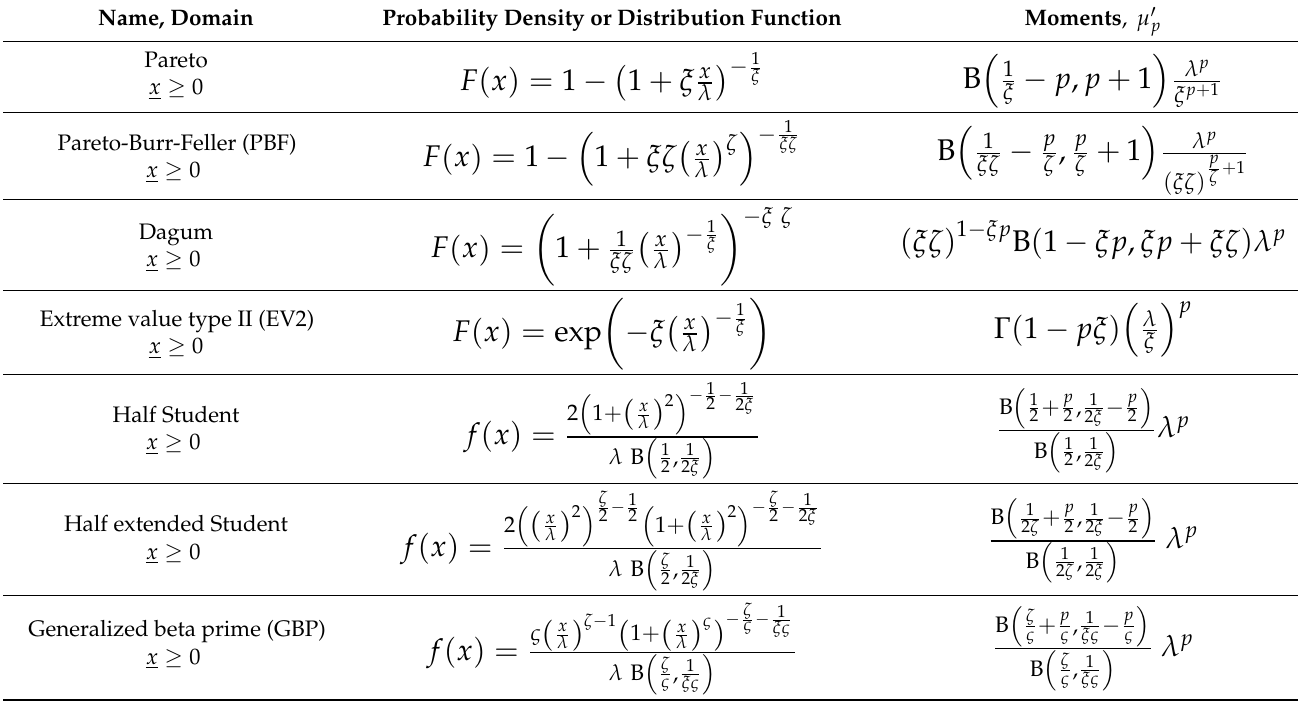
Table 4. Non-central moments of common distributions with upper-tail index ξ (moments and cumulants exist for p < 1/ ξ ). Here, the cumulants do not have simple explicit expressions but can be readily calculated from Equation